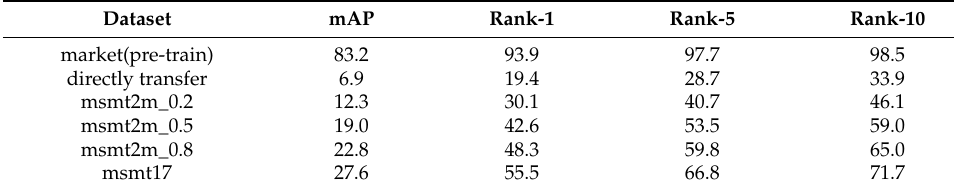
Table 2. The results of ablation experiments for Market1501 to MSMT17 dataset.